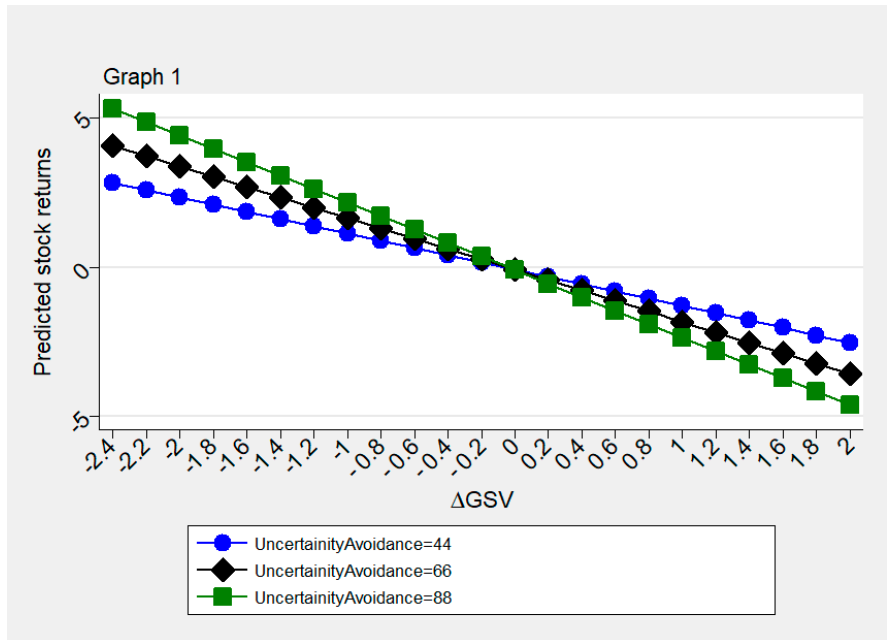
Figure 3. Relationship between stock returns and the change in investors’ attention considering different levels of uncertainty avoidance. The graph is formulated by using the mean and ±1 standard deviation of ∆ GSV and stock returns. The line (L2) with the embedded rhombus depicts the mean value for the uncertainty avoidance index, while the line (L1) with embedded circles represents the lower values of the index and line (L3) with the embedded squares represents the highest values of the uncertainty avoidance index.